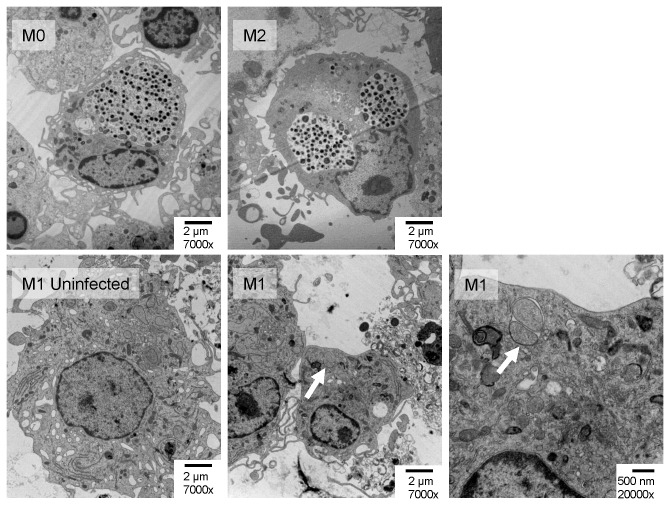
Electron microscopy of infected polarized macrophages demonstrates productive growth in M0 and M2 macrophages but induction of
Chlamydia
 persistence in M1 macrophages.Polarized BMDM infected for 24 hr prior to processing for electron microscopy. Mature
Chlamydia
 inclusions were seen in M0 and M2 macrophages (top panels). Bottom left panel shows representative uninfected M1 macrophage. Mature inclusions were not seen in infected M1 macrophages. Small inclusions with enlarged amorphous particles, consistent with
Chlamydia
 in the persistent state, were seen frequently in infected M1 macrophages (arrows, bottom panels).